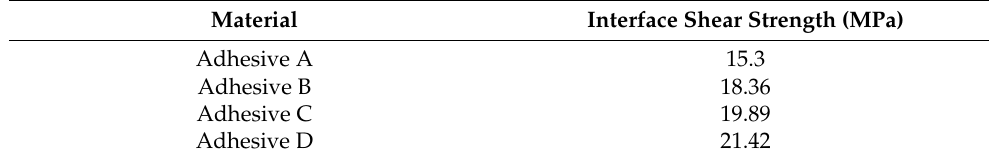
Table 3. Shear strength of different adhesives.